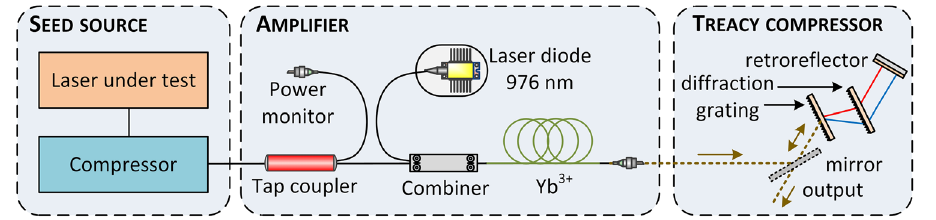
Figure 1. Schematic of the gain-managed nonlinear amplification